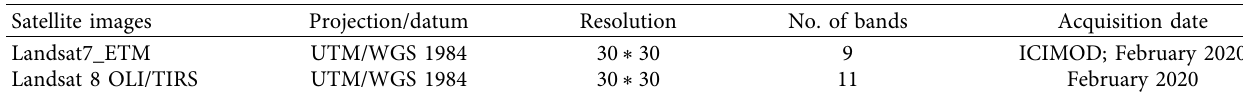
Figure 1: Map of Nepal showing the study area. Table 1: Image characteristics of the satellite